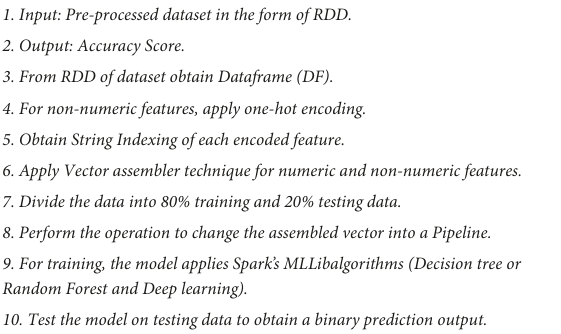
ALGORITHM 2 Classifiers Framework Using